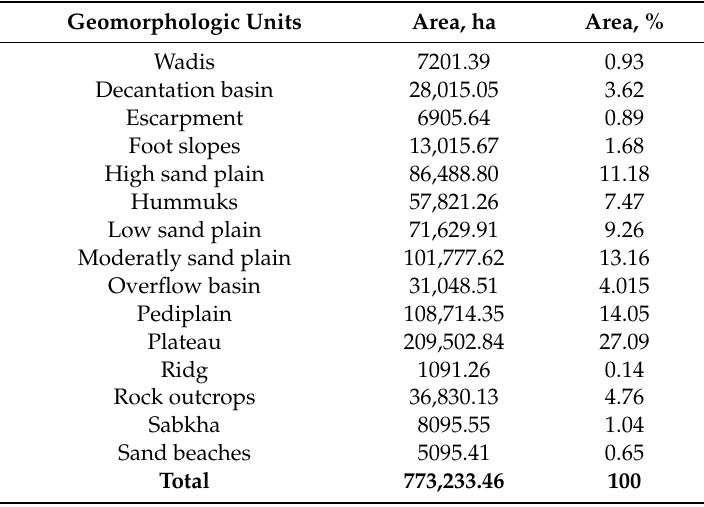
Figure 4. Geomorphological map of the study area. Source: modified after Mohamed et al. [30]. Table 2. The areas of geomorphological